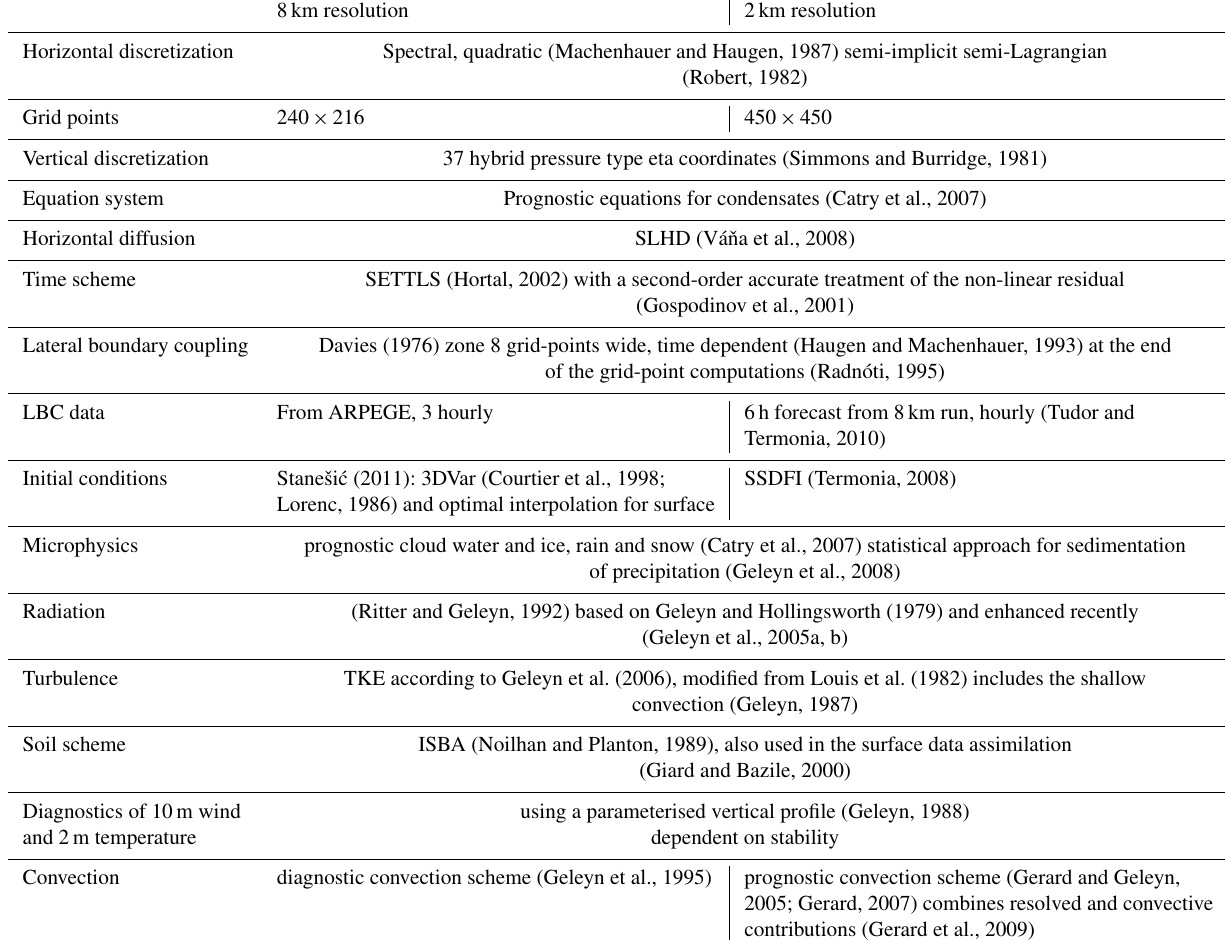
Table 1. Details of the operational model characteristics.